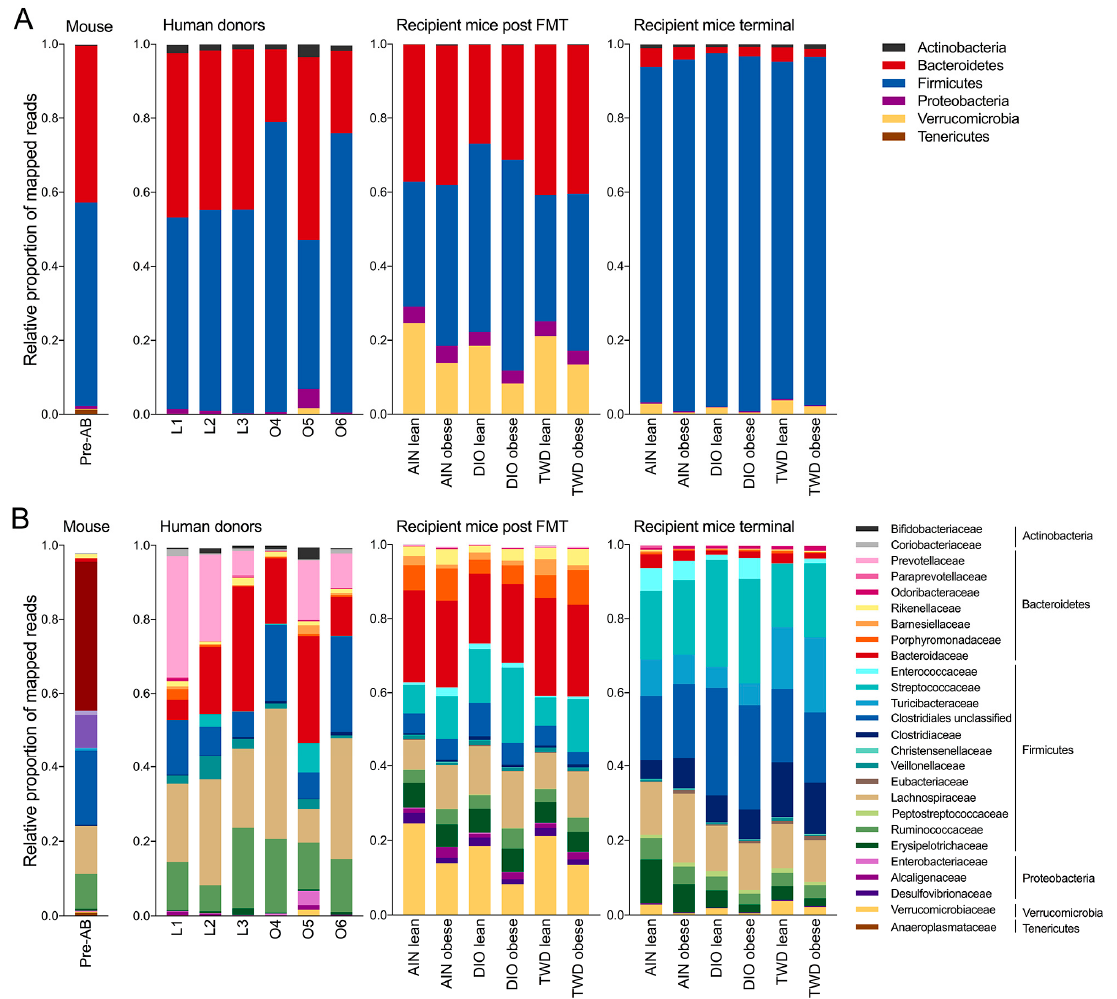
Figure 5. Classification of human or mouse fecal bacteria by phyla or family. Data shown are the relative abundance of bacteria to annotated phyla ( A ) or family ( B ) for the initial mouse microbiome (pre-AB), the original human donors, the recipient mice after the last fecal transfer from human donors, or the recipient mice at the end of the study. Taxonomic classifications for individual recipient mice post-fecal microbiome transfer (FMT) and necropsy (terminal) are provided in Figures S4 and S8. Abbreviation: AB, antibiotic.